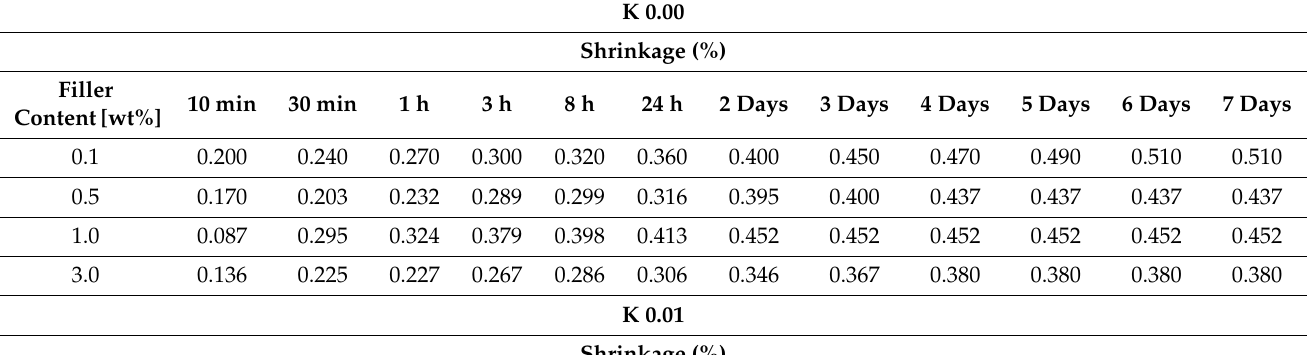
Table 8. Shrinkage of Q2-7358 resin-based pressure-sensitive adhesives with clinoptilolite. K